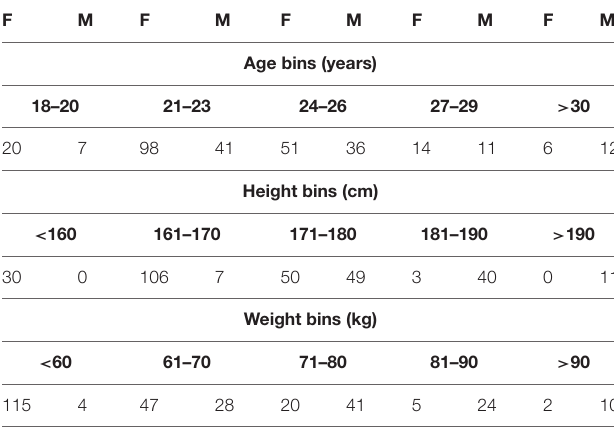
TABLE 1 | Distribution of age, height, weight by gender (F = female, M = male) of